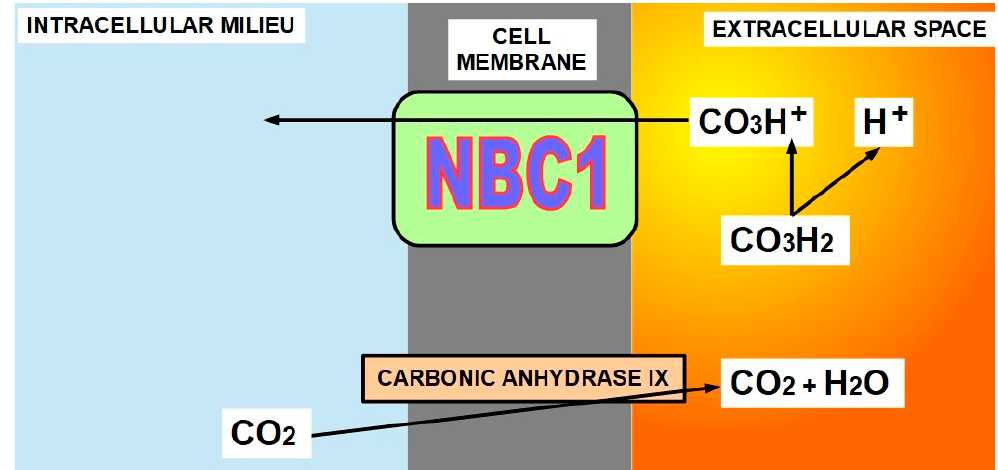
Figure 4. Membrane carbonic anhydrase IX generates carbonic acid through hydration of CO 2 .